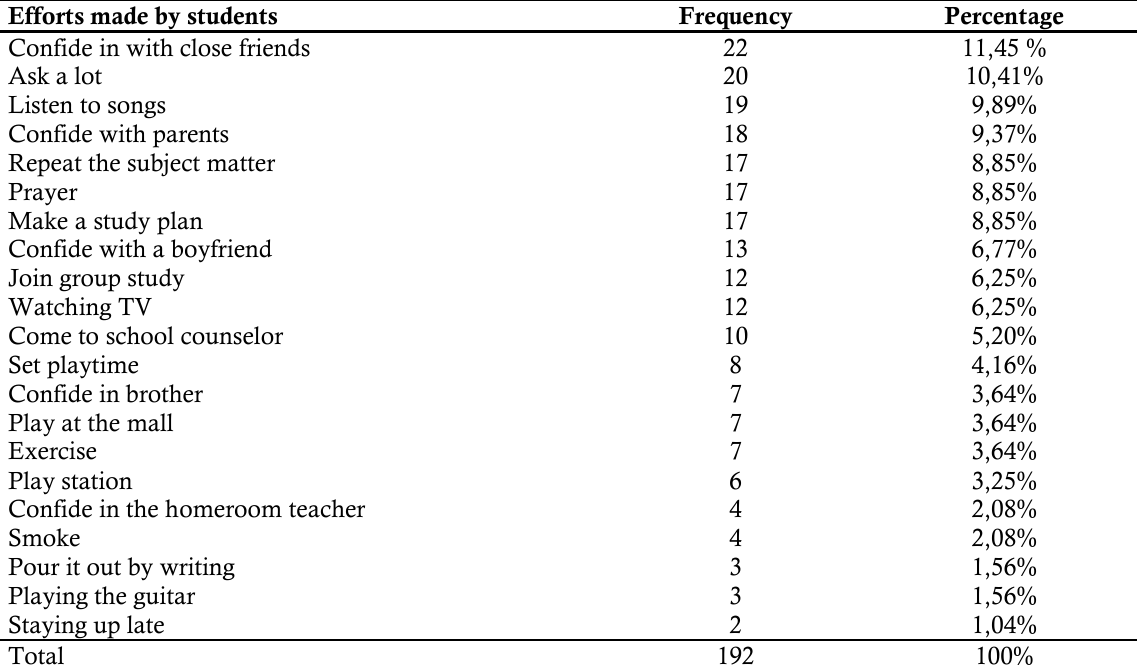
Table 2: Efforts made by students in overcoming learning